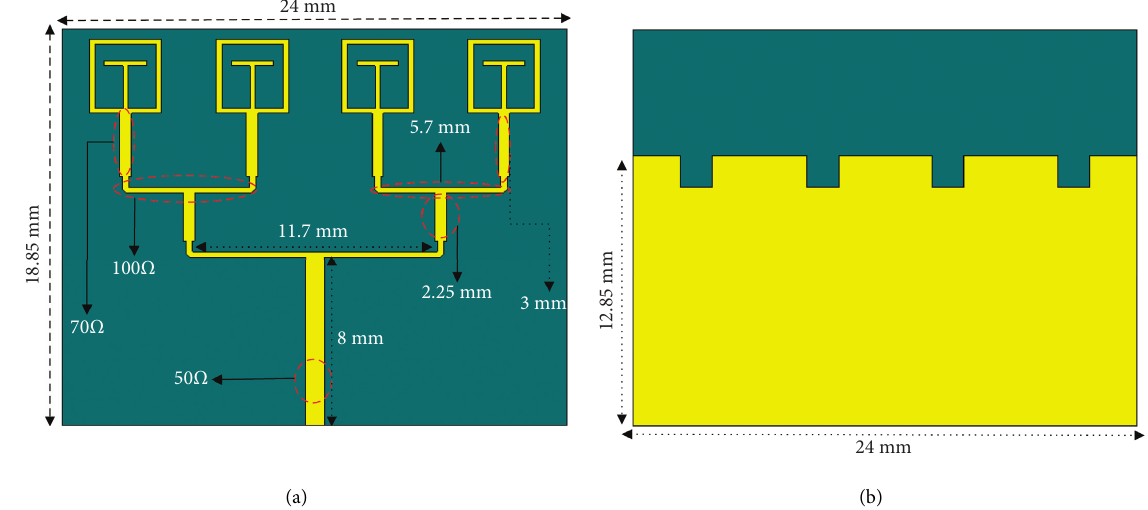
Figure 5: Four-element antenna array: (a) front view; (b) back view.